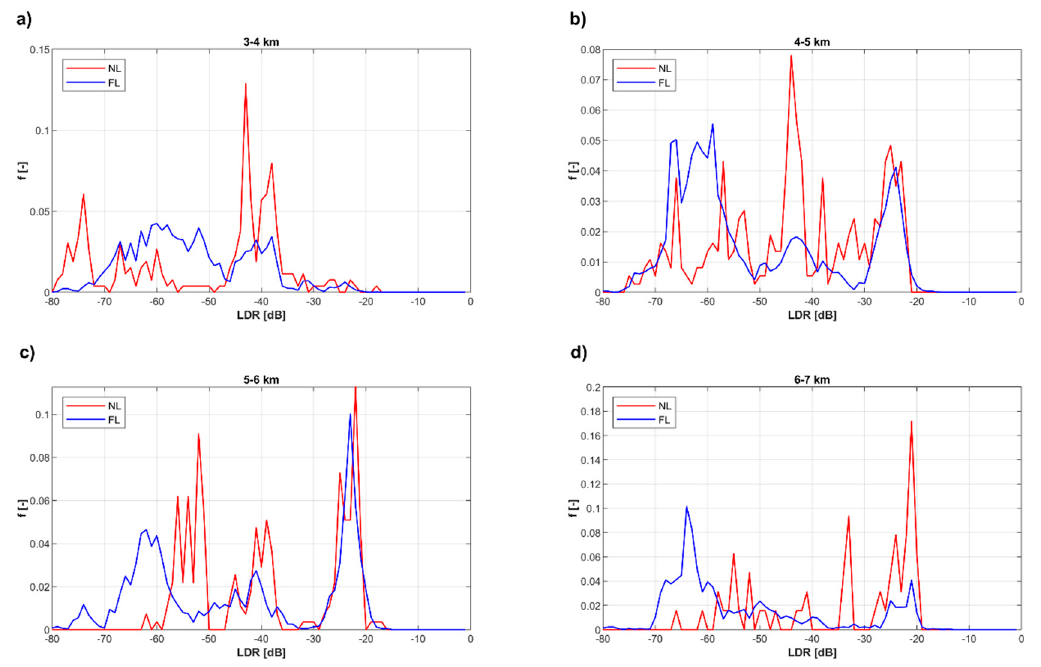
Figure 11. Frequency of LDR (f[ − ]) at an elevation of: ( a ) 3–4 km, ( b ) 4–5 km, ( c ) 5–6 km and ( d ) 6–7 km during thunderstorms observed at the Milešovka observatory for NL (red curve) as compared to FL (blue curve), when taking into account similar vertical profiles of graupel and hail concentrations. Y-axis represents the height [m] above the cloud radar situated at an elevation of 837 m a.s.l.